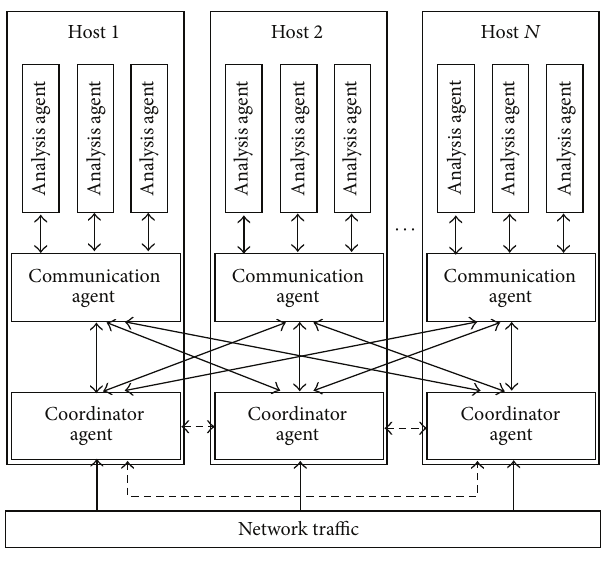
Figure 1: The MAS-IDS